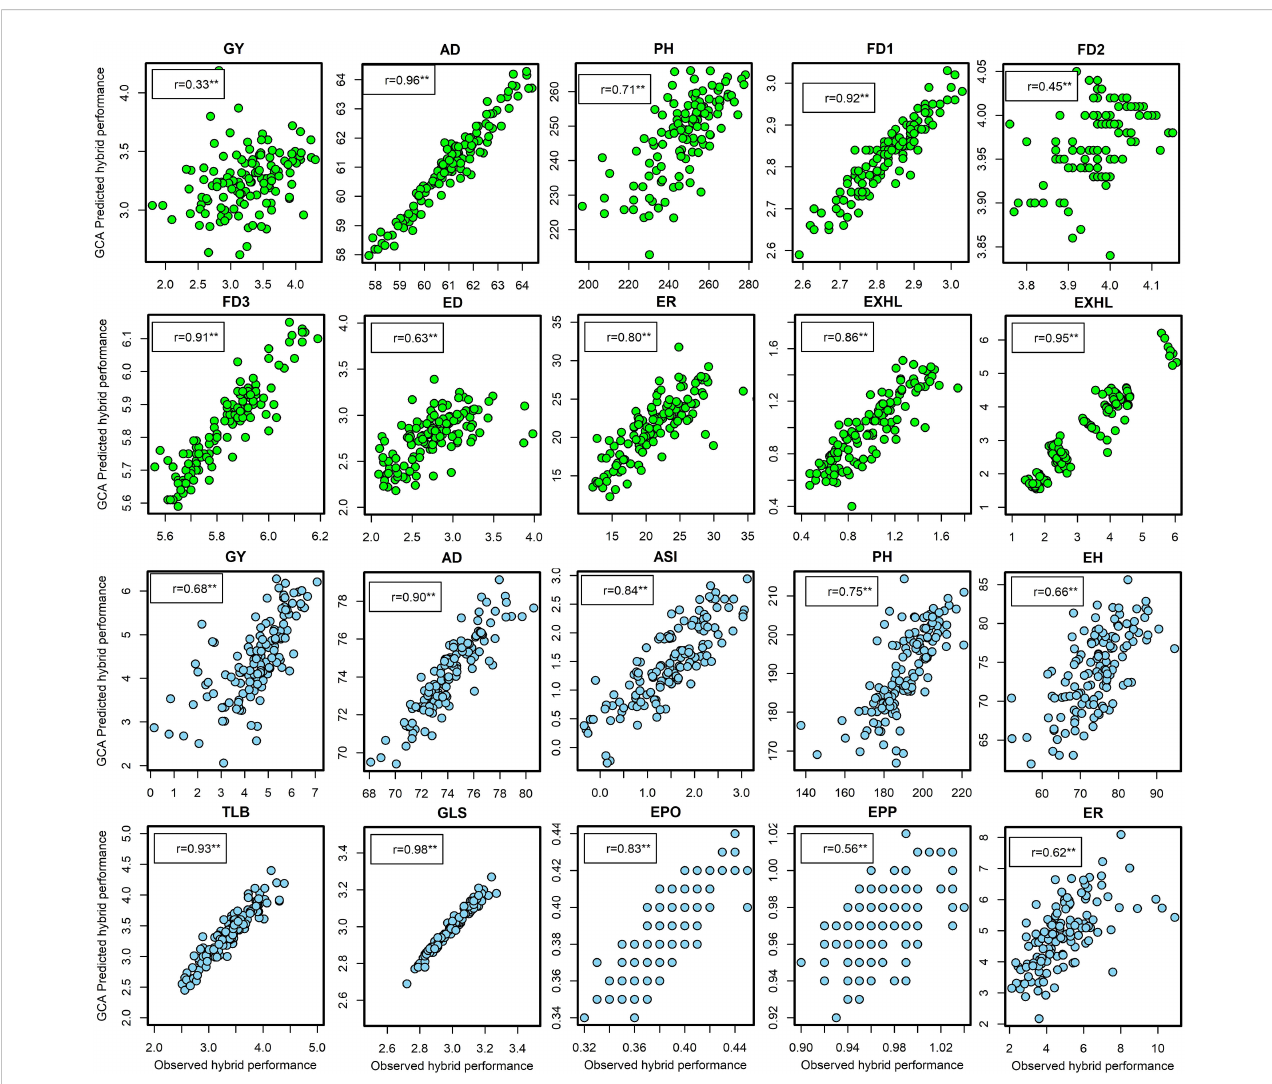
FIGURE 2 Leave-one-hybrid-out cross validated r values between general combining ability (GCA) based predicted hybrid performance and observed hybrid performance for grain yield and other agronomic traits evaluated under arti fi cial infestation (in green dots) and under optimum management (blue dots) in three to fi ve environments in experiment I. **Signi fi cant at the 0.01 probability level. GY, grain yield; AD, days to anthesis; PH, plant height; FD1, FD2, FD3, mean foliar damage scores at 7, 14 and 21 days after arti fi cial infestation, respectively; ED, ear damage; EXHL, number of exit holes; TLGTH, cumulative tunneling length; ER, number of rotten ears in %. ASI, anthesis to silking interval; EH, ear height; TLB, turcicum leaf blight; GLS, gray leaf spot; EPO, ear position; EPP, ears per